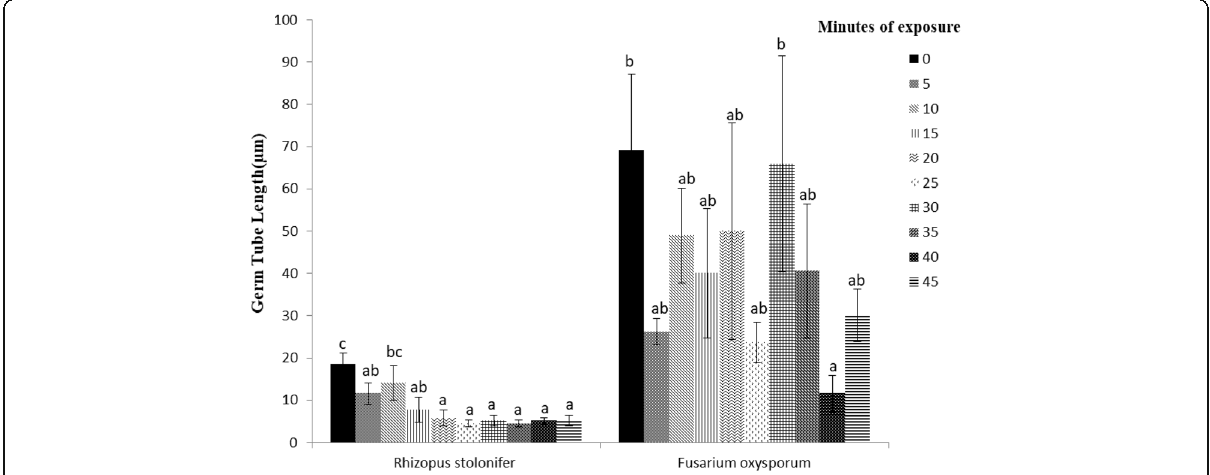
Fig. 2 Germ tube length of Rhizopus stolonifer and Fusarium oxysporum after exposure to gasoline emission and incubation at 28